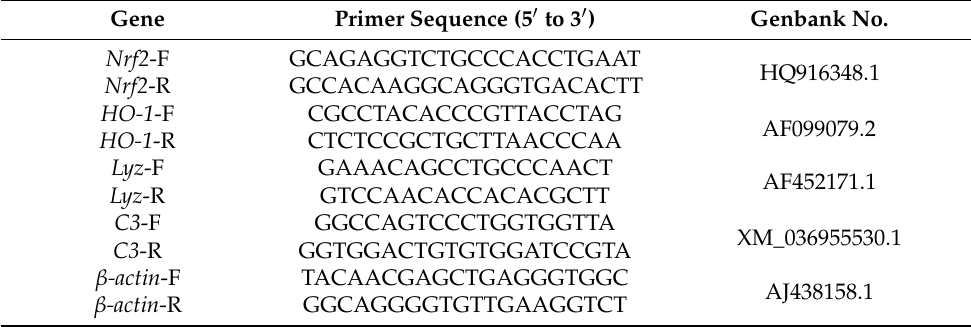
Table 2. Primer information of Real-time fluorescent quantitative